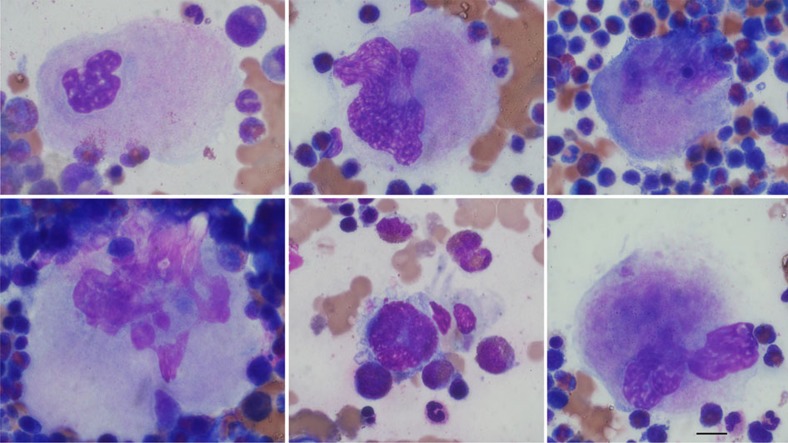
Bone marrow megakaryocyte morphology from Patient 1.Diagnostic bone marrow aspirate showing normal megakaryocytes with multilobed nuclei and large cytoplasm indicating normal morphology. Images were acquired from marrow smear preparations after Wright–Giemsa staining. Magnification × 60, bar=10μm.